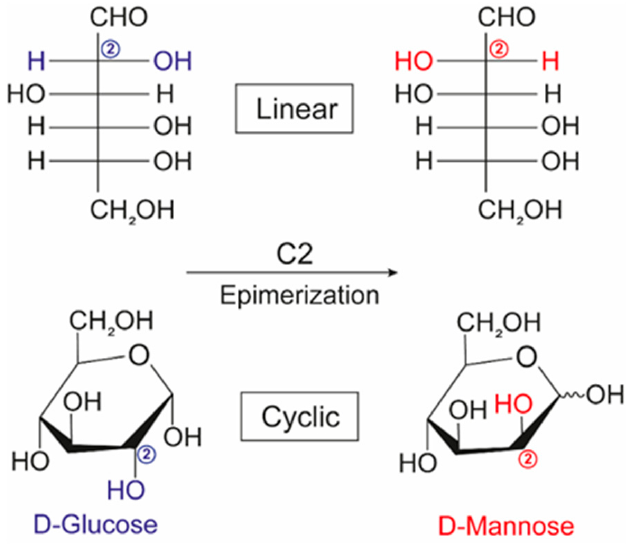
Figure 18. Scheme showing the difference between D-glucose and D-mannose in linear and cyclic form. Table 4. Performance of niobium-based catalysts for the conversion of glucose into different prod- ucts—from 2010 to date.